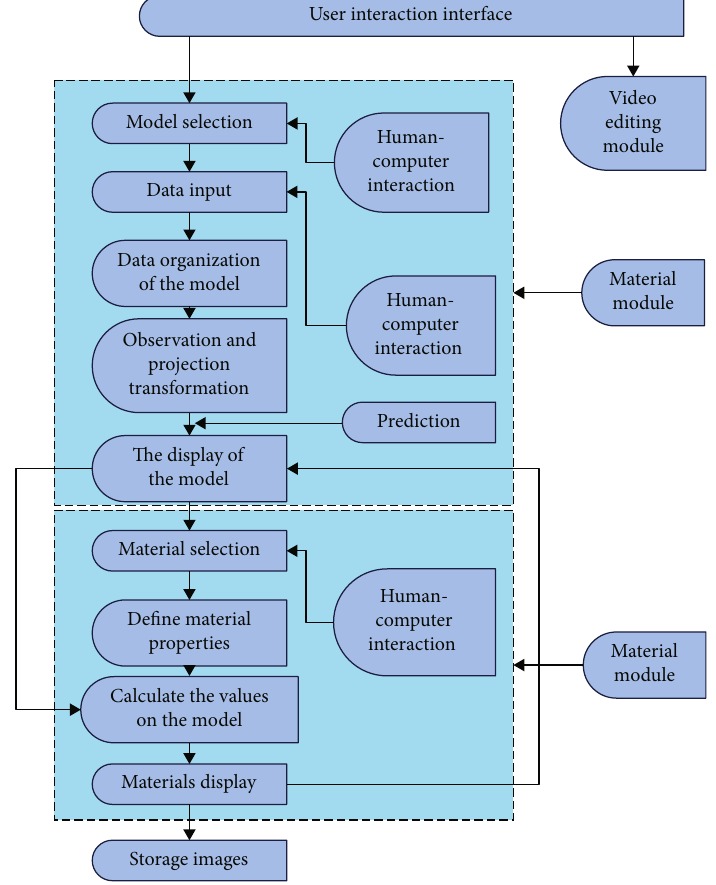
Figure 7: Flowchart of the